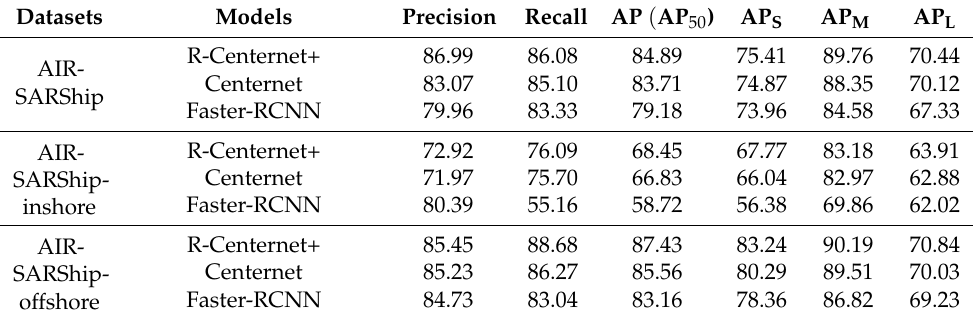
Figure 18. The P-R curves of AIR-SARShip dataset. Table 9. Experimental results on the AIR-SARShip dataset.